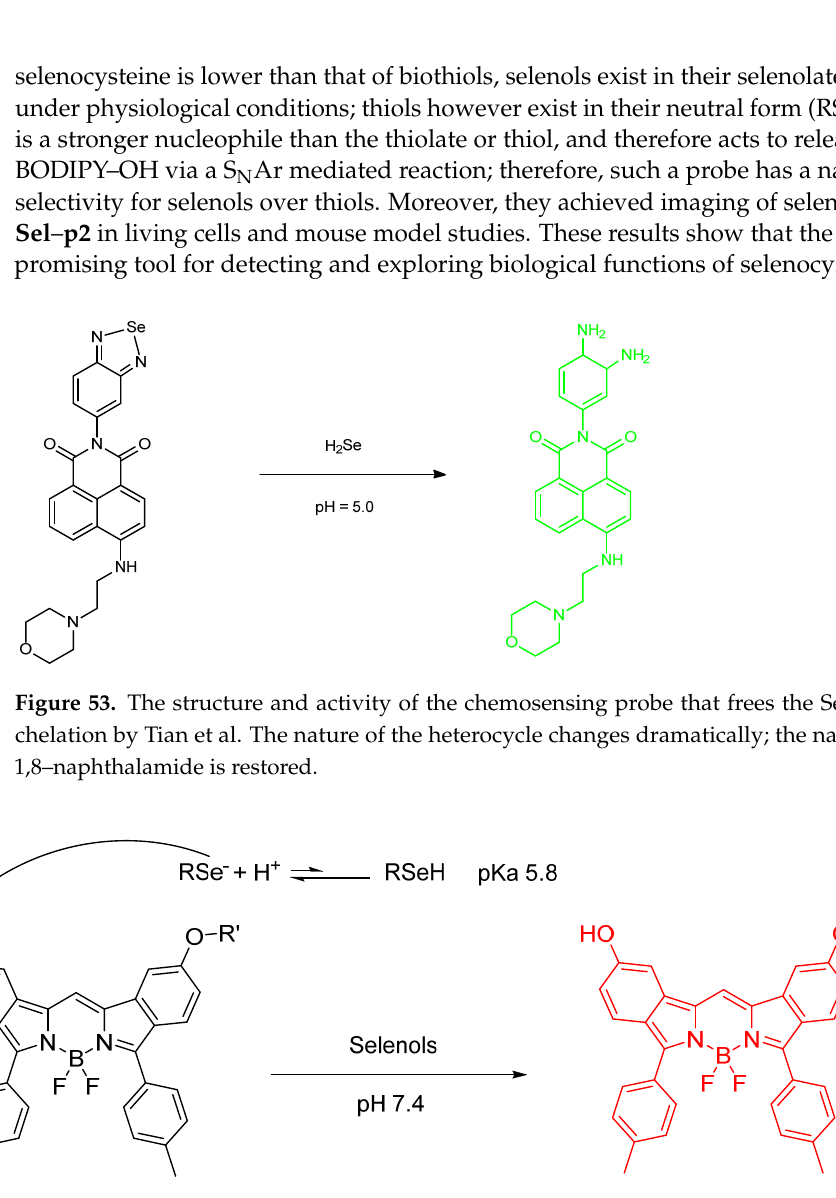
Figure 53. The structure and activity of the chemosensing probe that frees the Se from the N , N – chelation by Tian et al. The nature of the heterocycle changes dramatically; the native color of the 1,8–naphthalamide is restored.